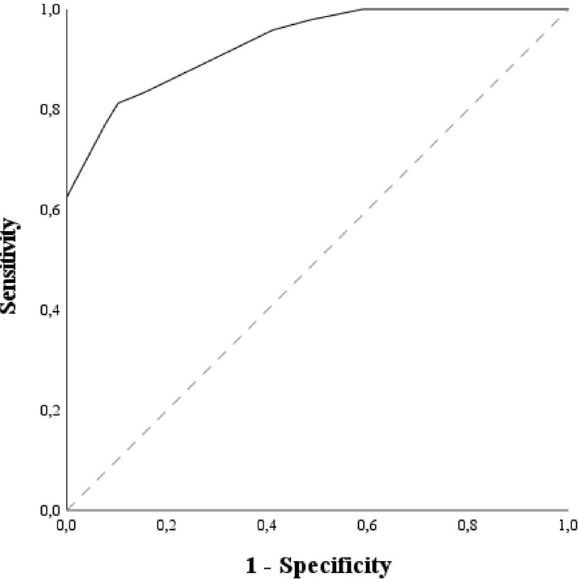
Figure 3. Receiver Operating Characteristic (ROC) Curve and Area Under the Curve (AUC) calculated for InCASEOf scoring system (solid line; AUC = 0.93). The gray dashed diagonal line serves as an imaginary reference line representing a non-discriminatory